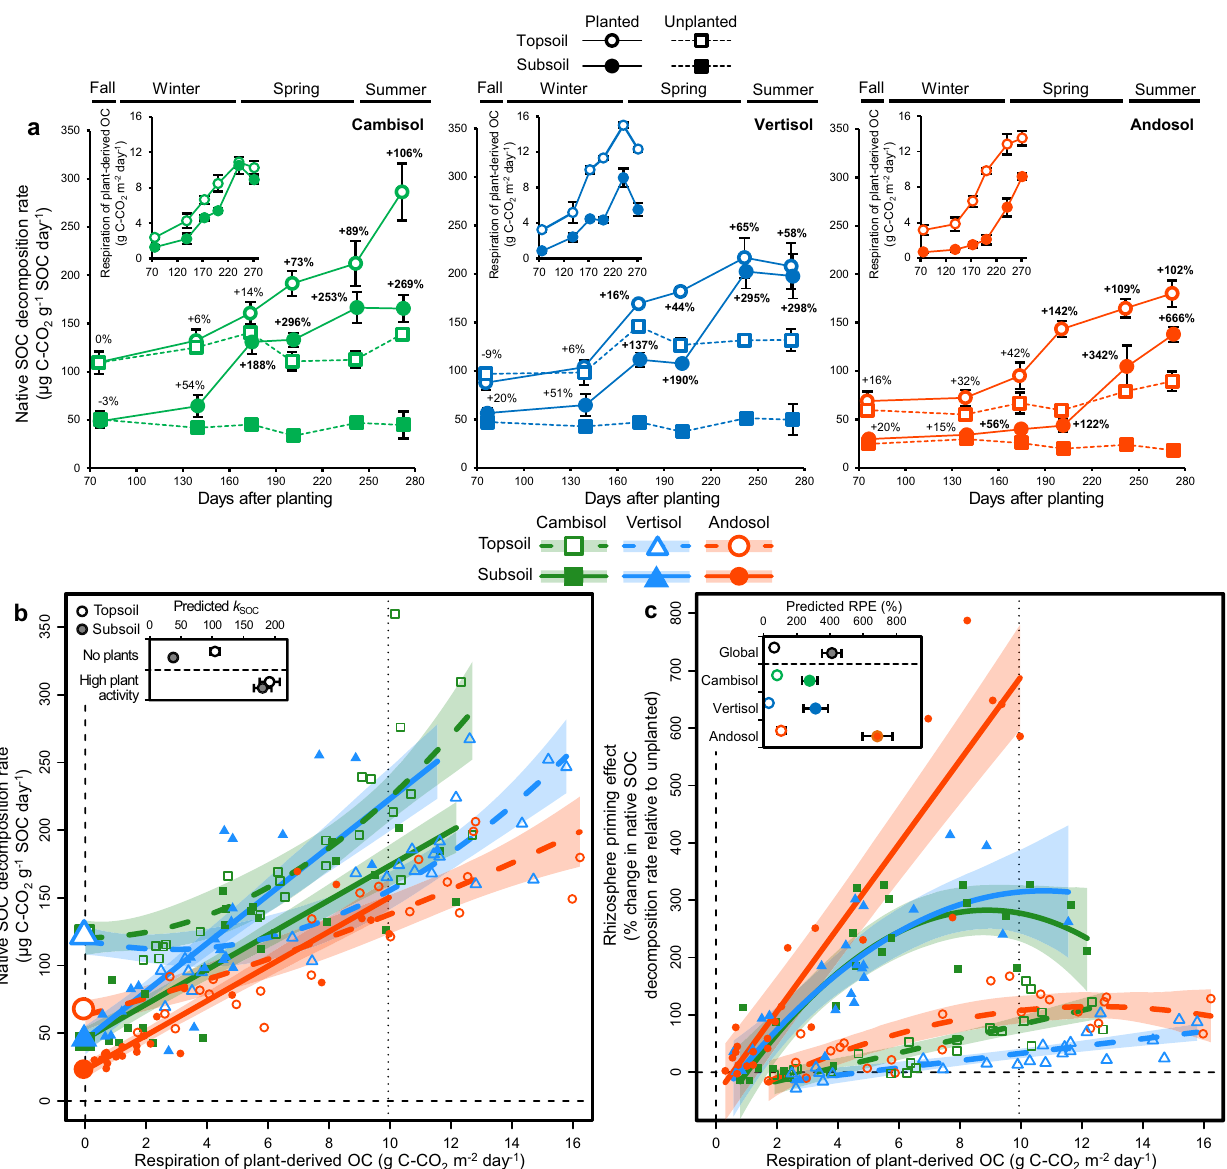
Fig. 3 | Root effects on the decomposition of native soil organic carbon (SOC) across time. a Temporal variation in native SOC decomposition rate ( k SOC ) and respiration of plant-derived organic carbon (OC, insets) at the microcosm scale in the fi rst series of incubations ( n =288 microcosm incubations). The respiration of plant-derived OC includes both plant autotrophic respiration and soil microbial heterotrophic respiration derived from rhizodeposits. Symbols with error bars show treatment means±standard errors ( n =4 replicate microcosms). Numbers abovethesymbolsrepresentrhizosphereprimingeffects(RPEs,in%changein k SOC for planted soils relative to the unplanted control). Signi fi cant RPEs are in bold (two-sidedt-test). b , c ResponseofnativeSOCdecompositionrate( b ,k SOC , n =288